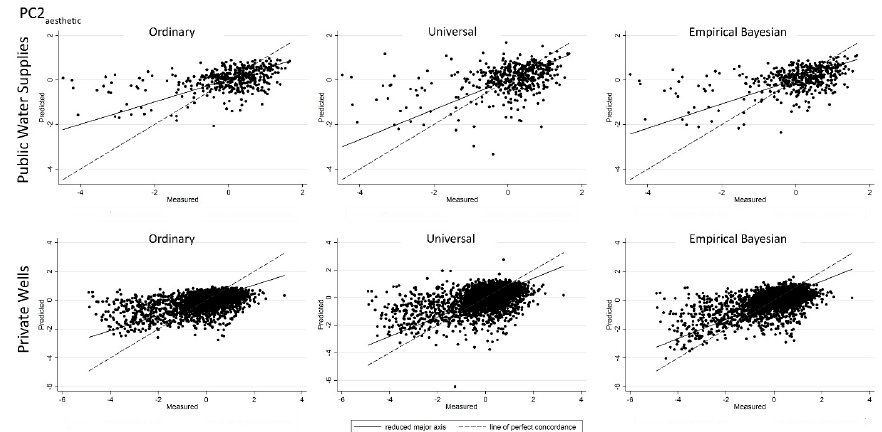
Figure A6. Predicted vs. measured values for PC2 aesthetic scores obtained from the cross-validation results for ordinary, universal, and empirical Bayesian kriging for: public water supplies ( top row ); and private wells ( bottom row ). Line of perfect concordance indicated by dashed line.